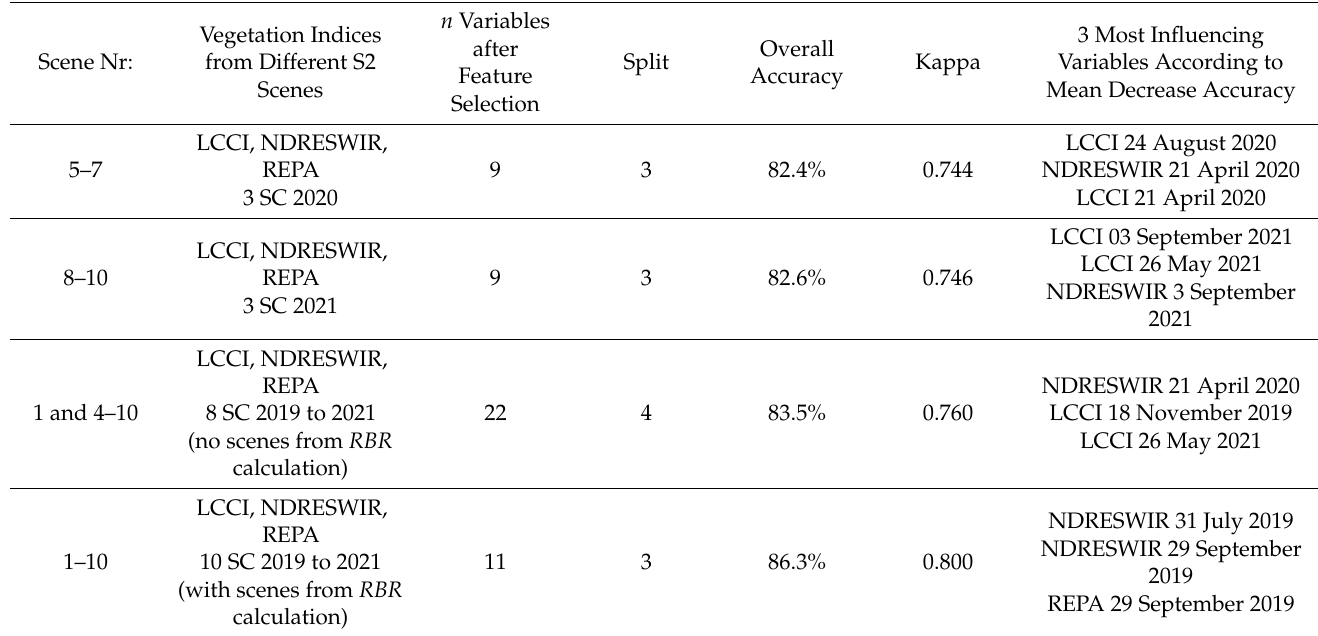
Table 6. Best Random Forest models based on OOB results after Feature Selection using three Vegetation Indices (LCCI, NDRESWIR, REPA) from different Sentinel-2 data recording